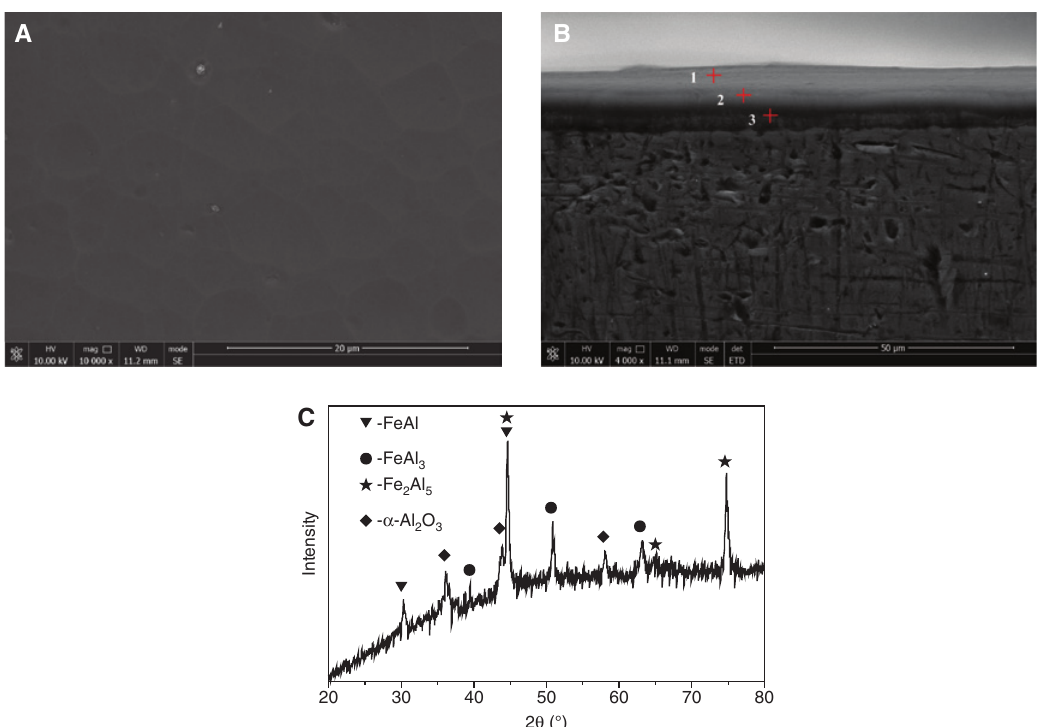
Figure 1: Morphology and phase of the AlY α coating: (A) surface morphology, (B) section morphology, and (C) GAXRD pattern.